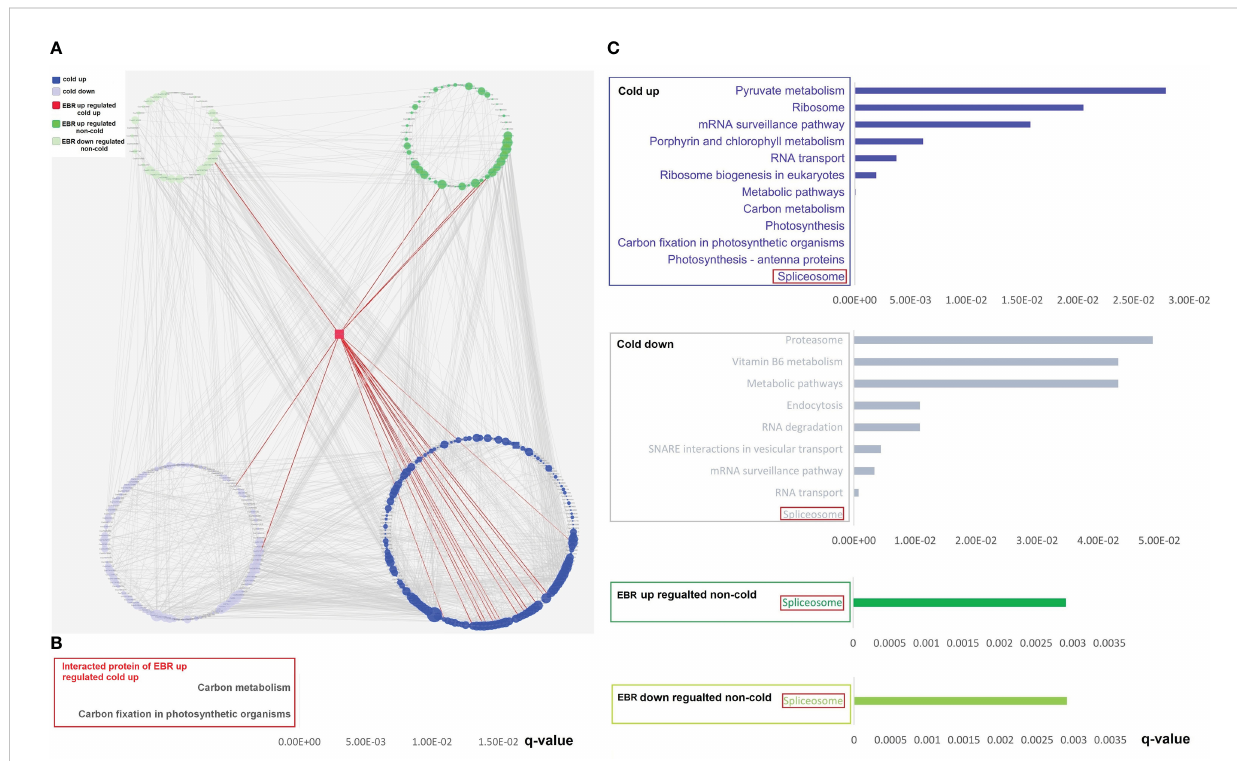
FIGURE 5 The PPI networks ’ construction and KEGG pathway analysis for differential phosphoproteins. (A) The construction of PPI networks for differential phosphoproteins; KEGG pathway of interacted proteins of EBR-upregulated cold-up (B) , cold-up, cold-down, EBR-upregulated non-cold, and EBR- downregulated non-cold phosphoproteins (C)